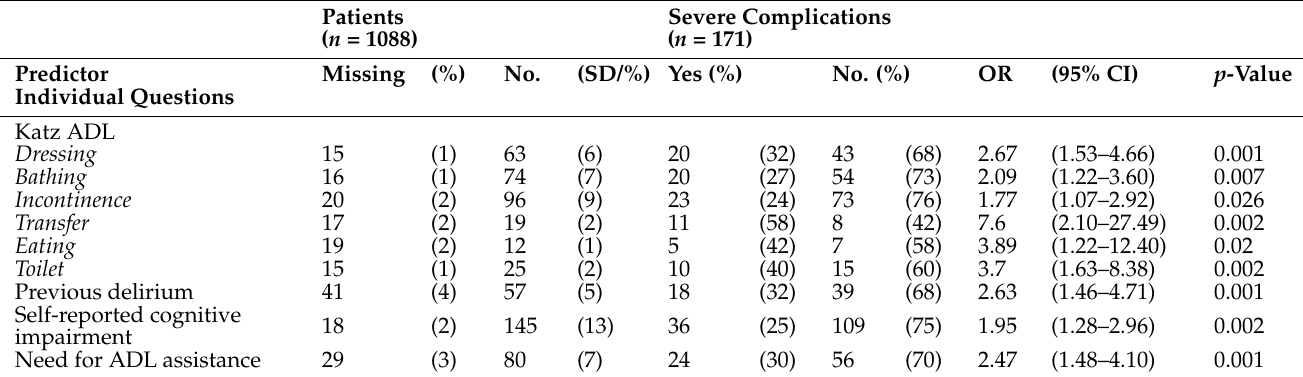
Table A2. Geriatric Predictors of Severe